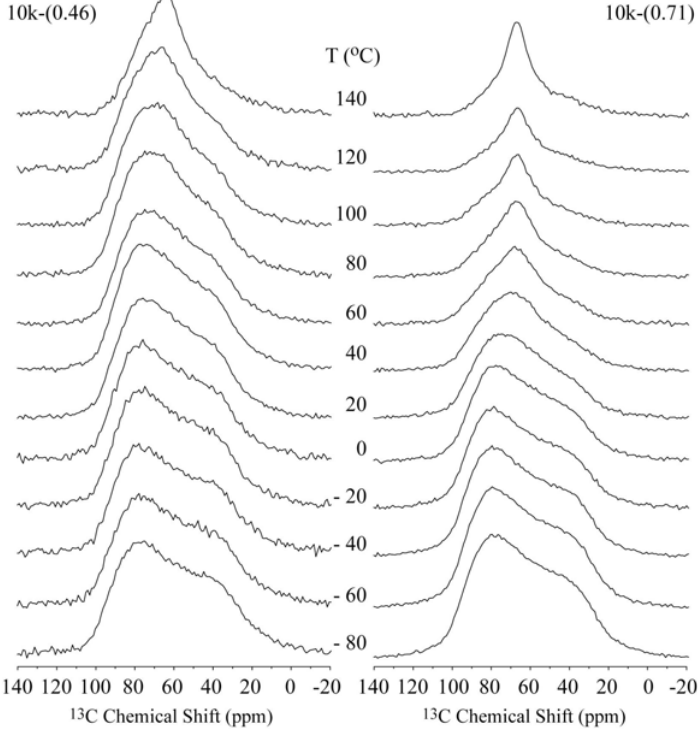
Figure 2. Temperature dependence of the 13 C NMR spectra obtained for the single- and double-layer nanocomposites 10k-(0.46) and 10k-(0.71), respectively.